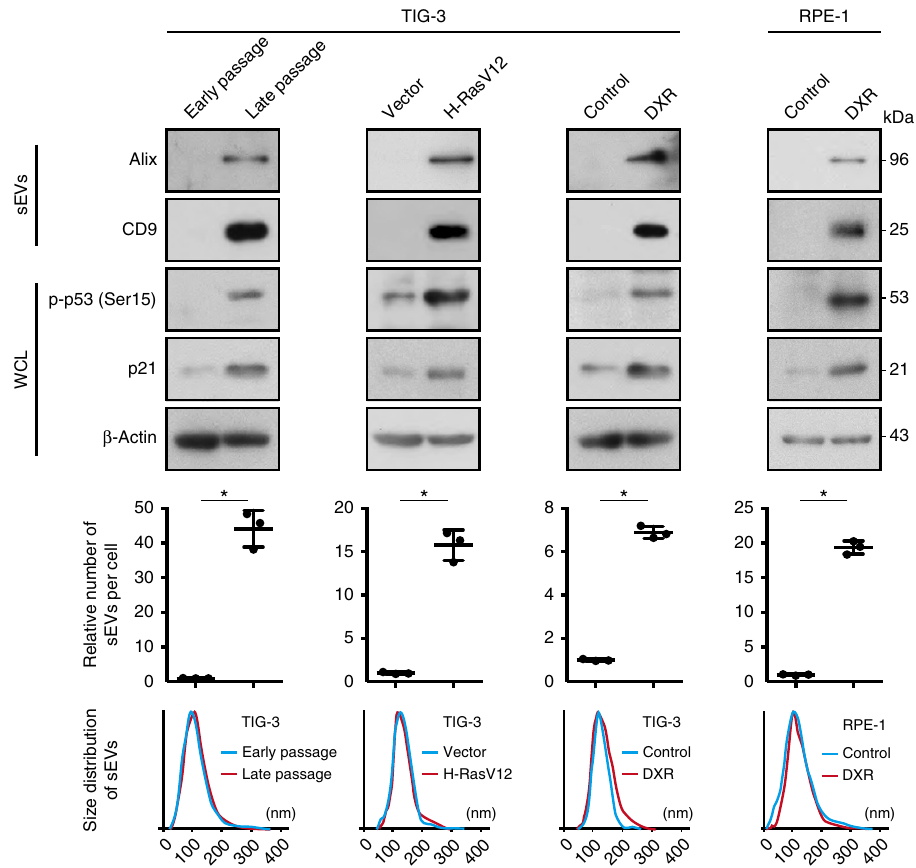
Figure 1 | Senescence increases the secretion of sEVs. Immunoblotting of Alix (exosome marker) and CD9 (sEV marker) in the sEV fraction and of phospho-p53 (Ser15), p21 and b -actin in the whole cell lysates (WCL) of pre-senescent control and senescent cells. Senescence was induced by serial passage, oncogenic Ras expression or DXR-treatment in TIG-3 or RPE-1 cells. Dot plots show the relative numbers of sEVs per cell. The number of sEVs in the sEV fraction was quantified using NanoSight. The bottom graphs show the size distributions of sEVs secreted from control and senescent cells. Cell densities were as following at 1day before starting CM preparation for sEV purification; subconfluent for pre-senescent TIG-3 and RPE-1 cells; 8 (cid:2) 10 2 cellscm (cid:3) 2 for replicative senescent TIG-3 cells; 1 (cid:2) 10 4 cellscm (cid:3) 2 for Ras-induced senescent TIG-3 cells; 5 (cid:2) 10 3 cellscm (cid:3) 2 for DXR-induced senescent TIG-3 cells; 1.4 (cid:2) 10 4 cellscm (cid:3) 2 for DXR-induced senescent RPE-1 cells. The CM to be used for sEV purification was prepared by culturing the cells in